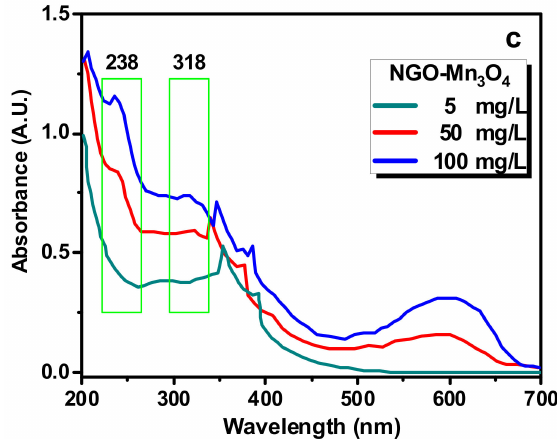
Figure 12. UV-Vis curves for RB5 on NGO–Mn 3 O 4 in 3 di ff erent RB5 concentrations (pH = 3, m = 0.01 g, V = 0.02 L).